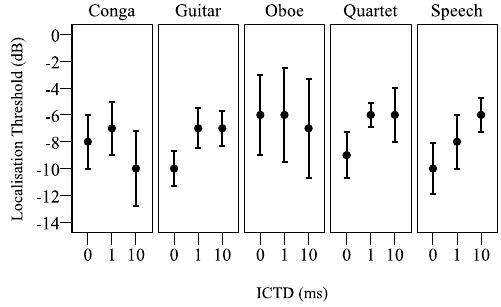
Figure 5. Medians and associated notch edges with the results for both presentation methods combined.